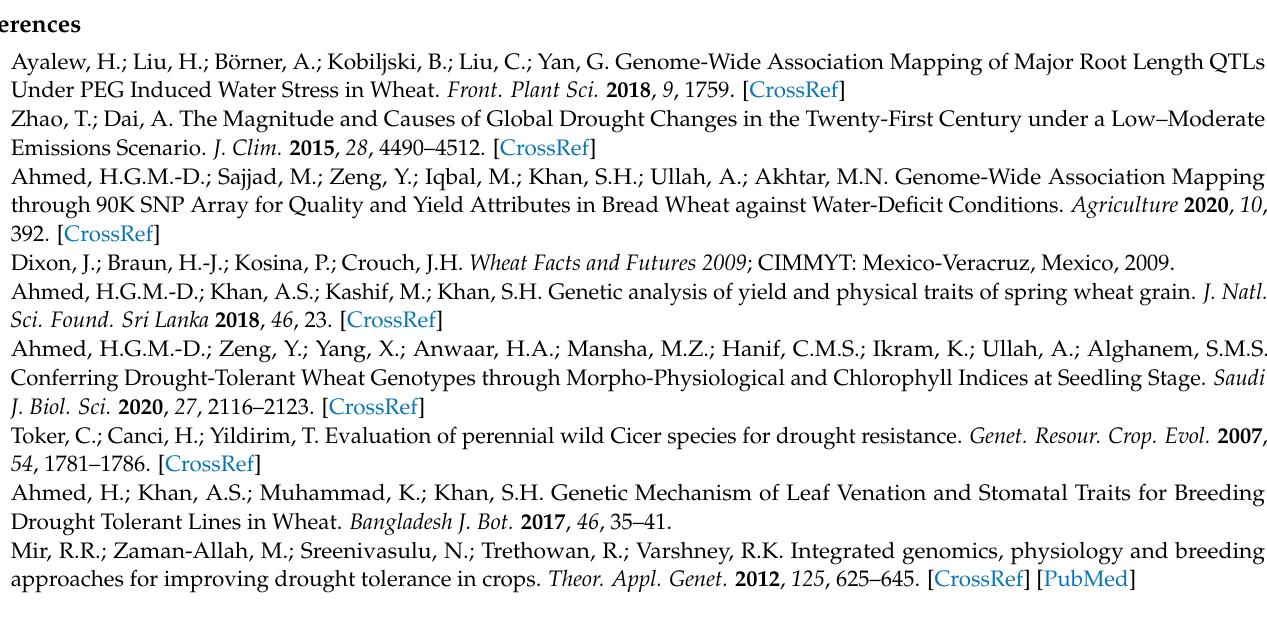
Table S3: GWAS Results under water shortage